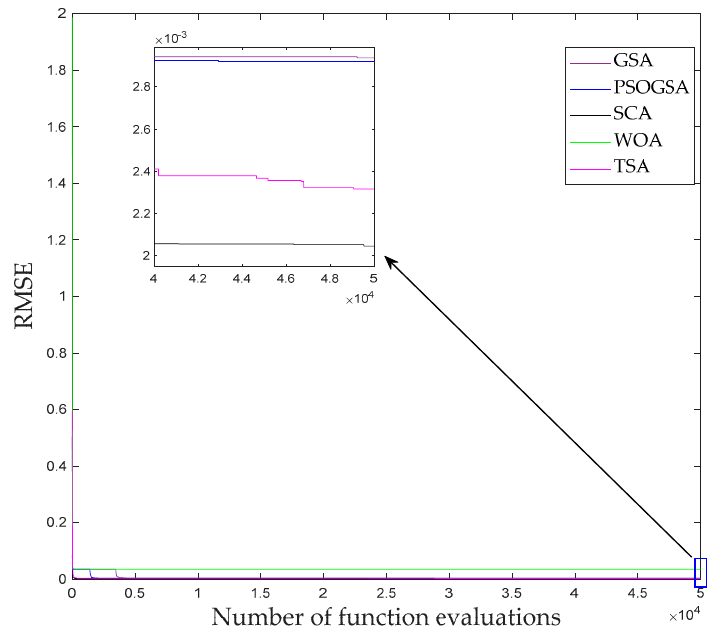
Figure 5. Convergence curve of TSA (Tunicate swarm algorithm) and the other four algorithms for single-diode model of Photowatt-PWP201 PV (Photovoltaic) Module.